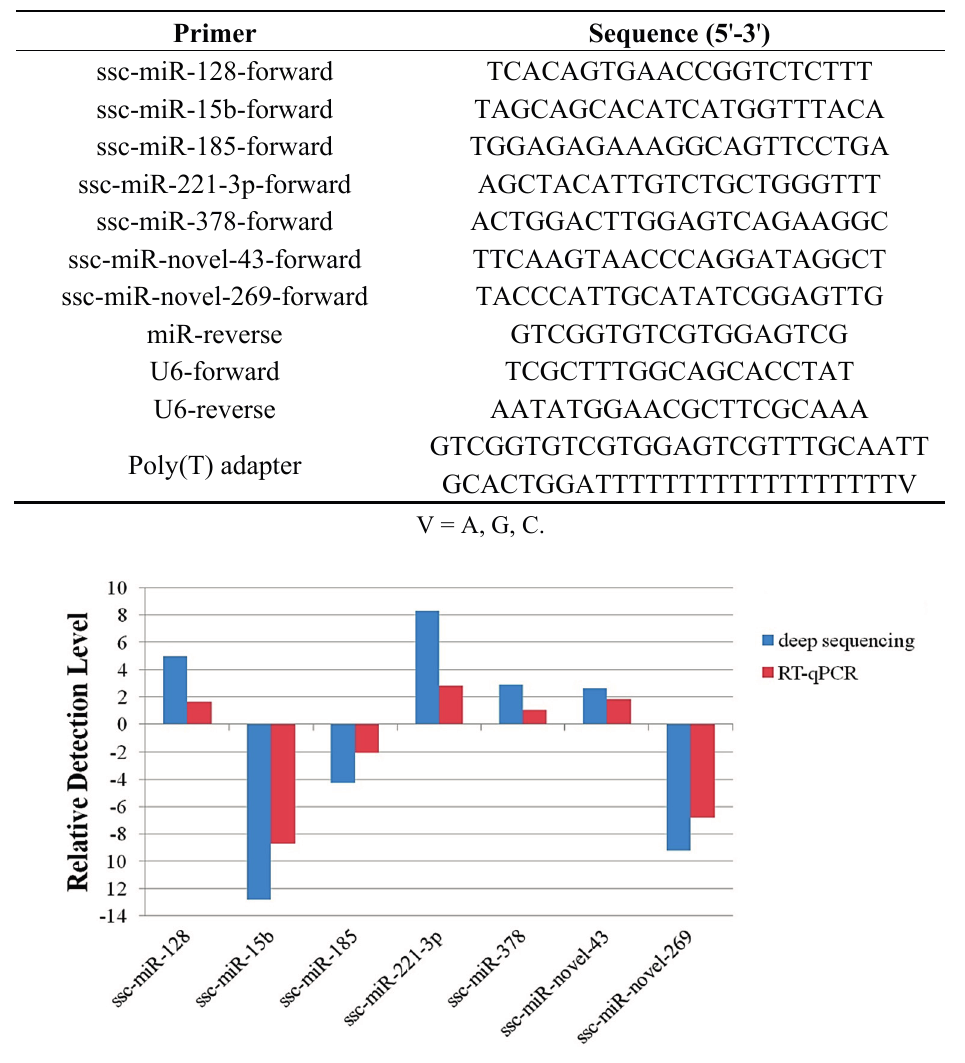
Figure 4. Validation of miRNA expression by